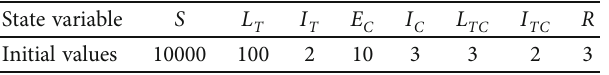
Figure 9: The impact of the contact rate of individuals ( β Table 2: The initial values of the state variables in the model equation